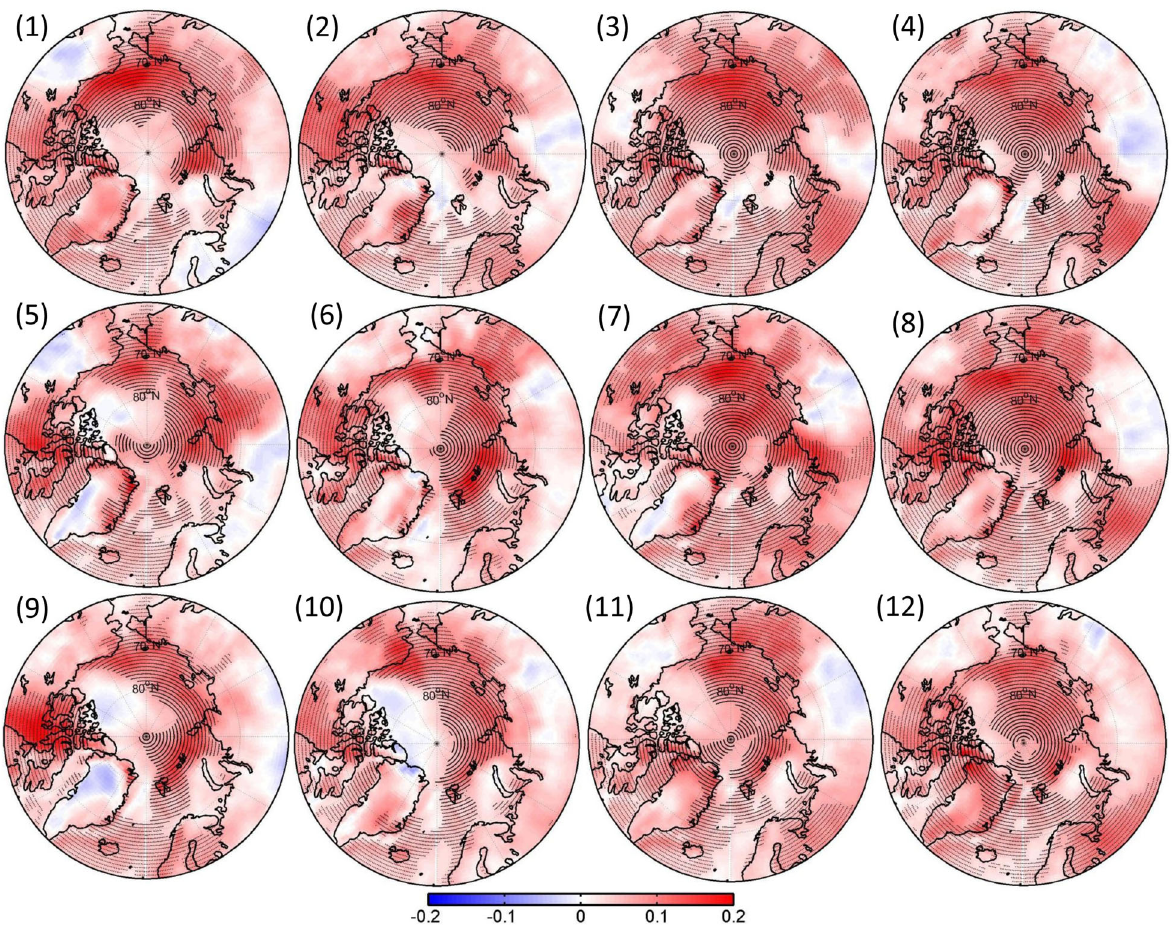
Fig. 10 Trends in surface air temperature for each node (unit: °C yr − 1